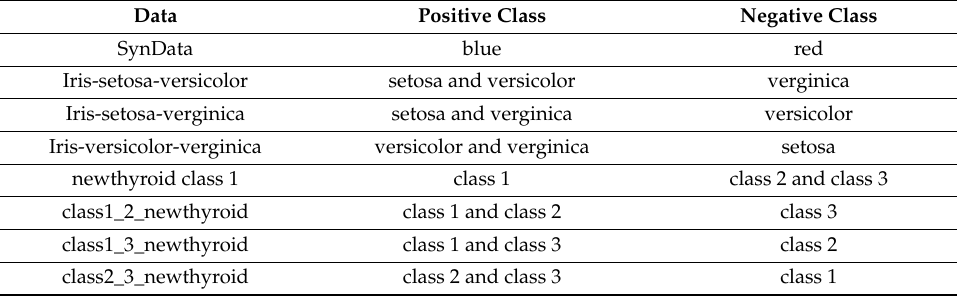
Table 1. Description of the data sets. Positive and negative